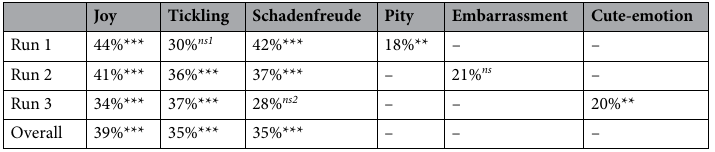
Table 2. Classification results for Experiment 1, separate for each run and across all runs (Overall). Shown are the hit rates (% correct) and their statistical significance (one-sample t-tests vs 25% guessing probability; Bonferroni corrected; *** p < .001; ** p < .01; ns1 p = .042 and ns2 p = .055 before Bonferroni correction; ns non- significant). – Laughter of this affective state was not presented in that experimental run.